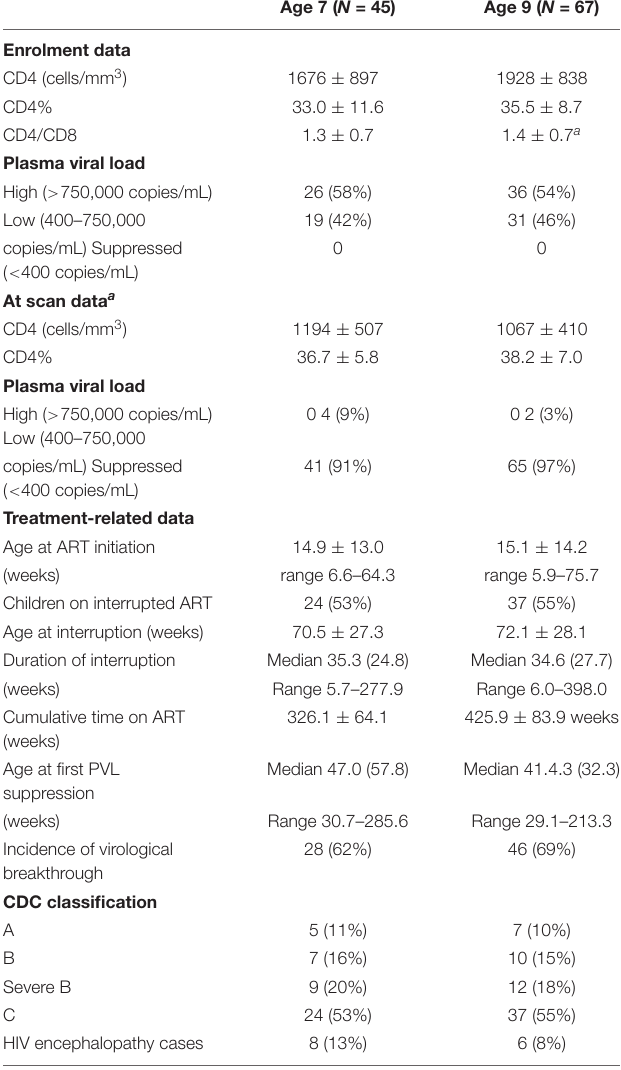
TABLE 2 | Clinical data for HIV + children scanned at 7 and 9